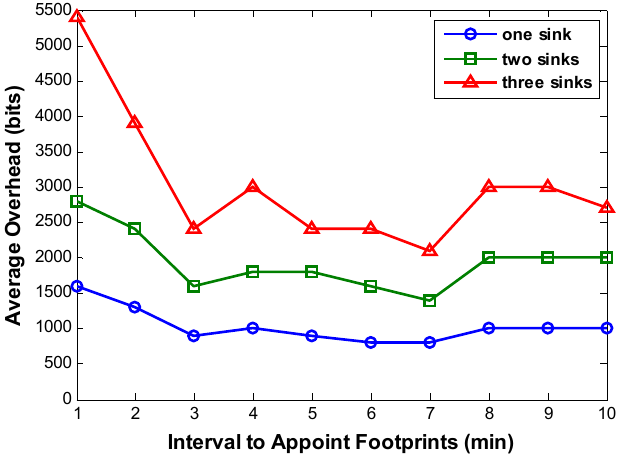
Figure 13. Average overhead with different footprint appointment intervals.